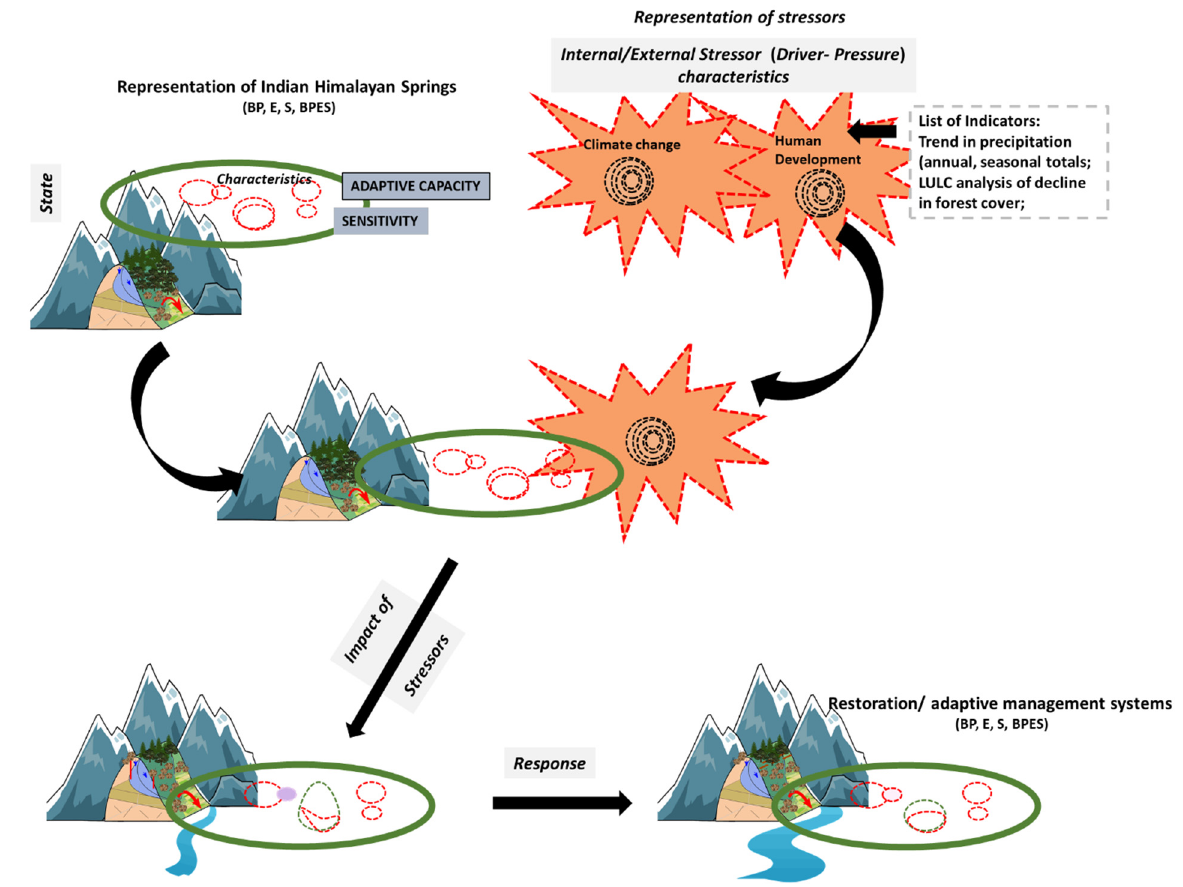
Figure 3. Conceptual framework.